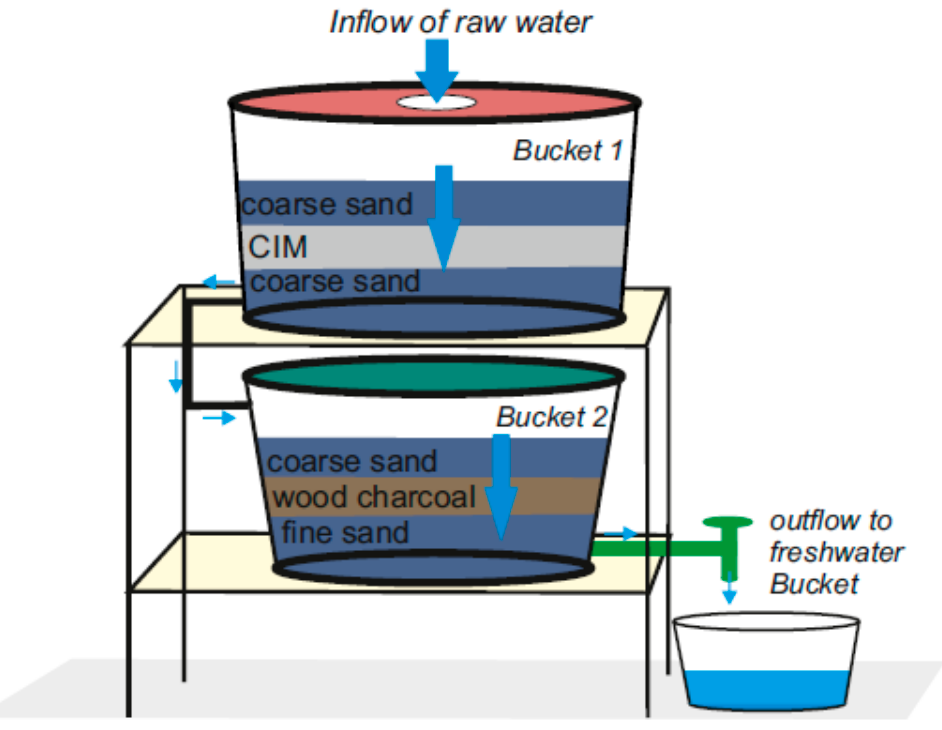
Figure 2. A conceptual sketch of the SONO filter initially developed for arsenic removal (adapted from Hussam and Munir [55]).